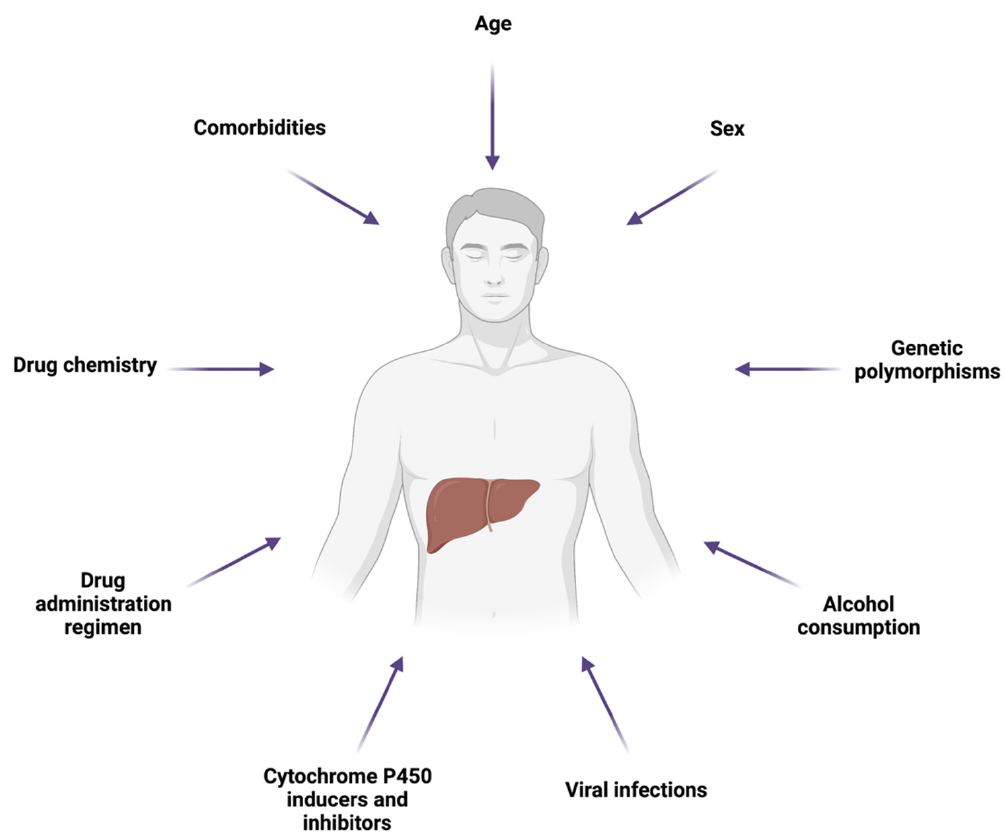
Figure 4. Schematic representation of the main factors affecting susceptibility to hepatic injury due to drug-induced mitochondrial toxicity. Created with Biorender.com (accessed on 21 February 2022; Toronto, ON, Canada).